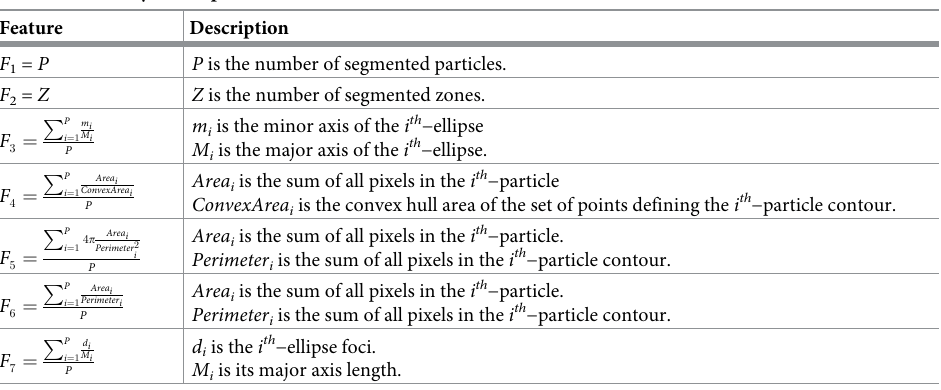
Table 1. Summary of computed